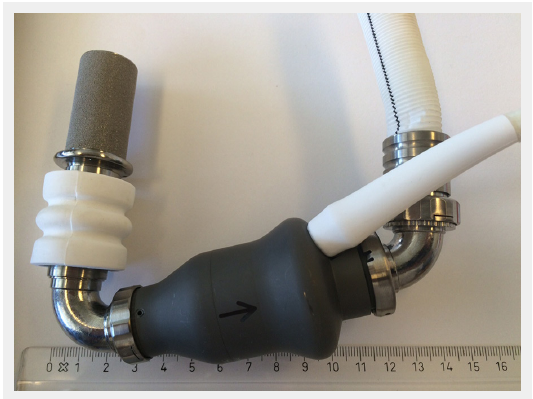
The HeartMate II (Thoratec Corporation, Pleasanton, California, USA) is a continuous flow axial pump with a magnetically activated impeller. It weighs 400 g and provides up to 10 l/min flow. It is the only ventricular assist device for destination therapy approved by the US Food and Drugs